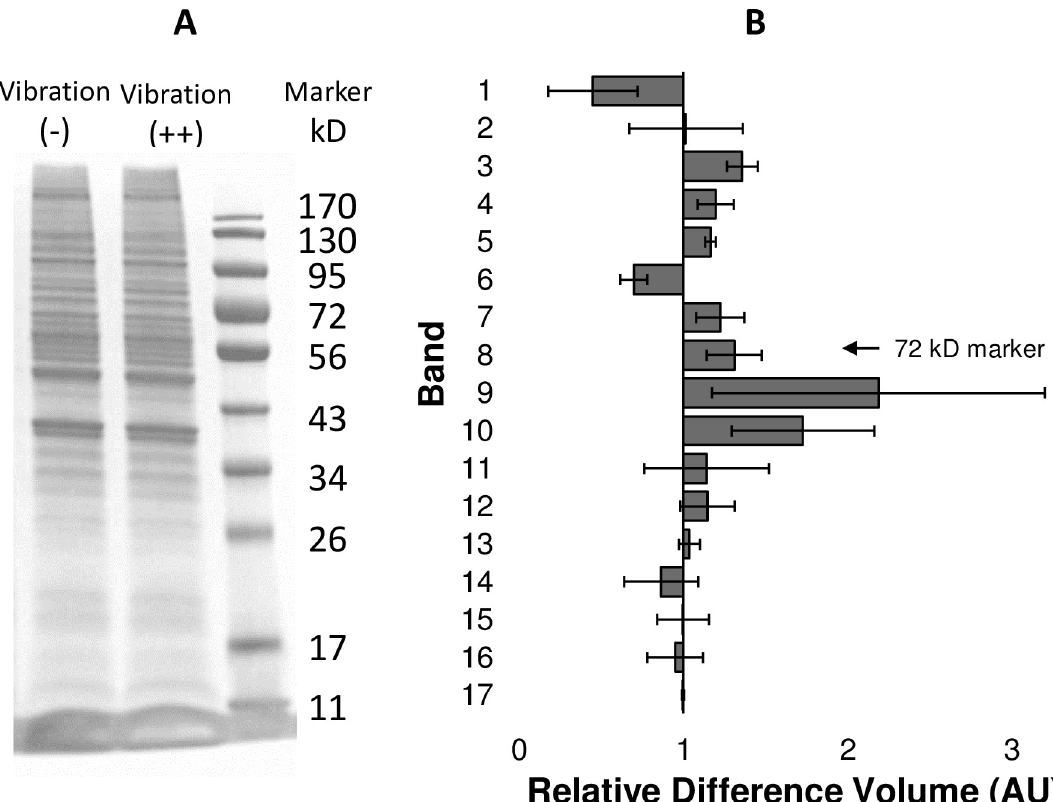
Fig 3. Vibration altered intracellular protein content. Representative protein bands obtained from HeLa cells without vibration and with vibration. Cells were lysed for total protein, separated by vertical electrophoresis and stained for total protein. Marker indicates 10 molecular marker bands corresponding to protein size (A). Seventeen bands from each lane were aligned based on relative front in comparison to relative front of marker bands. Arrow indicates placement of the 72kD marker. An arbitrary volume unit was assigned to each band by analysis software (B). Larger volumes were assigned as band density increased indicating an increase in protein levels. Band volumes for cells exposed to vibration are displayed as relative volume difference to cells not exposed to vibration. Numbers great than one indicate increase in vibration stimulated cells. Data shown as average relative difference volume ( ± sem for three independent experiments). Of note are bands 8, 9 and 10 (clustered around 72kD) that were increased in HeLa with vibration in comparison to HeLa without vibration. Alternatively, bands 1and 6 were decreased in HeLa with vibration in comparison to HeLa without